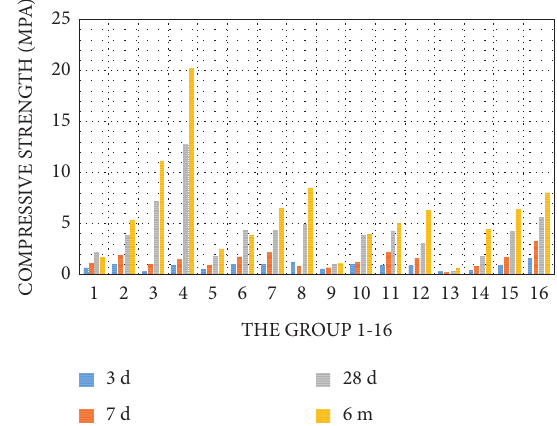
Figure 2: 3d, 7 d, 28d, and 6-month compressive